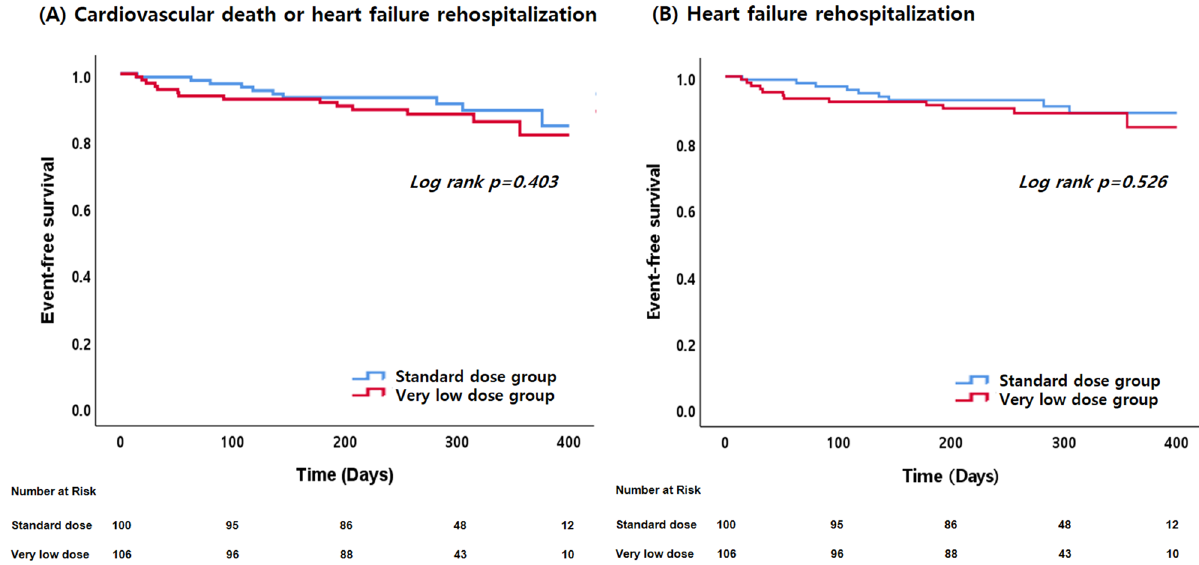
Figure 1. Kaplan–Meier curve for clinical outcomes between very low-dose sacubitril/valsartan and standard dose group. Event-free survival of the composite-end point (cardiovascular death or heart failure rehospitalization) (Panel A ) and heart failure (HF) rehospitalization (Panel B